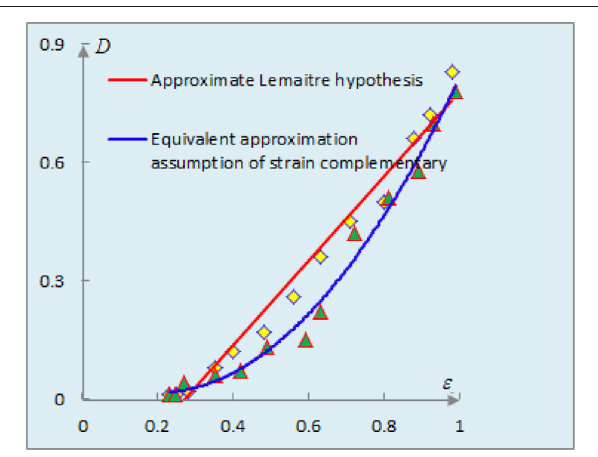
FIGURE 1 | Comparison of damage development under the two